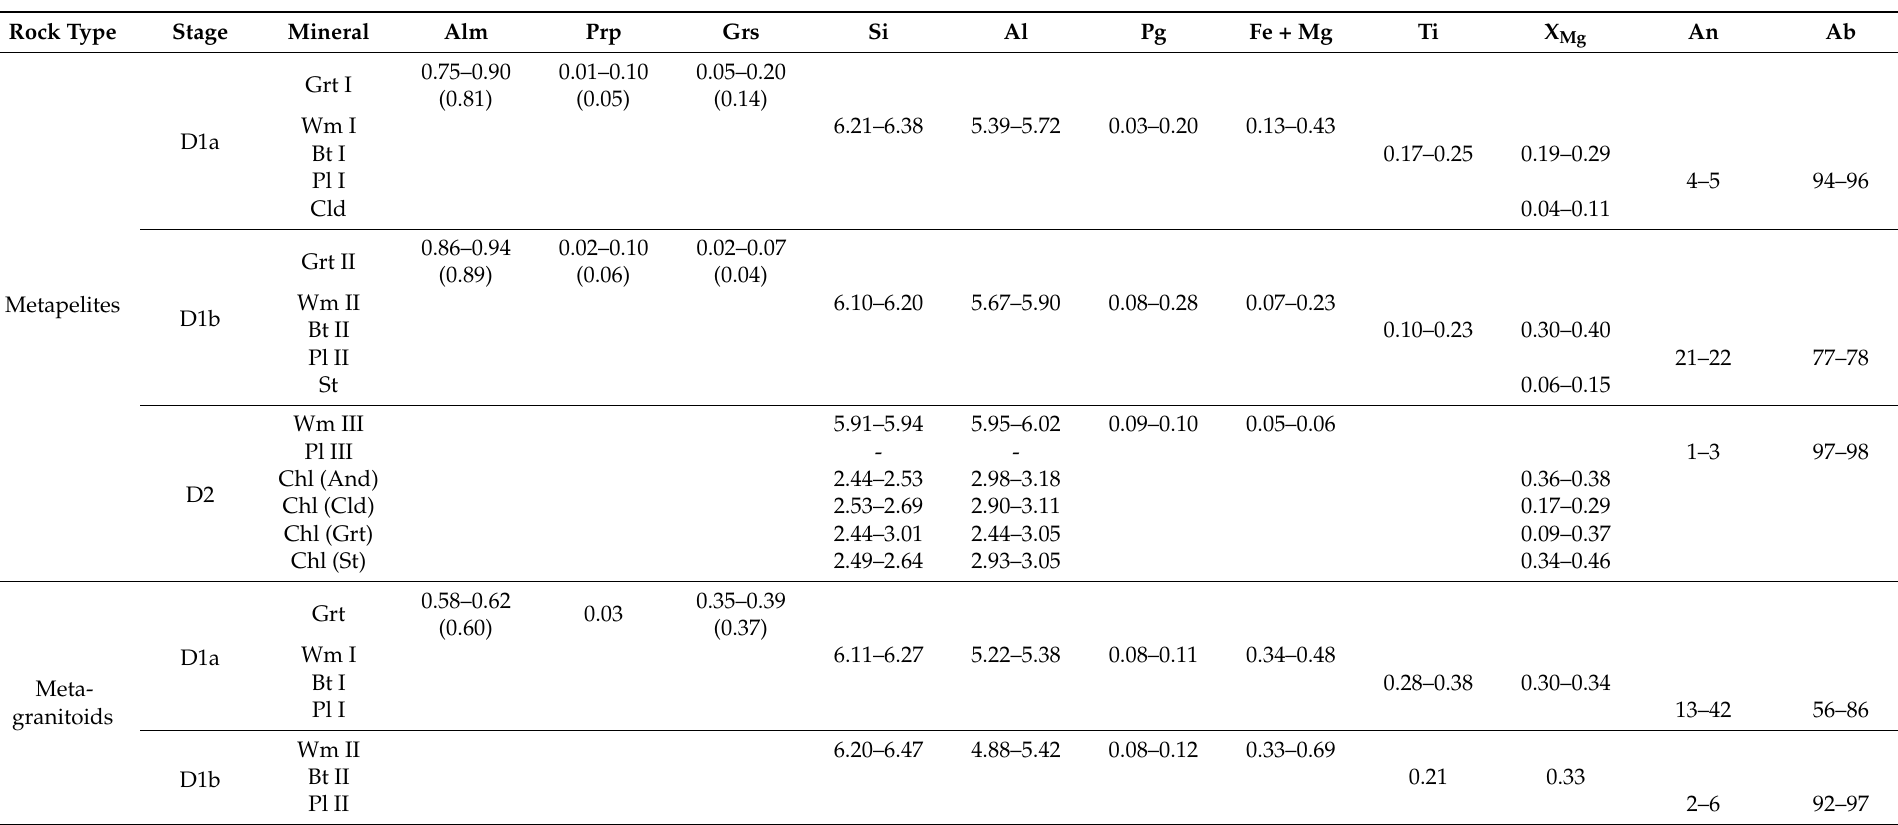
Table 2. Synthesis of mineral chemical analyses. Stoichiometric formulae are calculated as follows: garnet at 8 cations and 12 oxygen atoms, epidote at 8 cations and 12.5 oxygen atoms, biotite and white mica at 22 oxygen atoms, chloritoid at 12 oxygen atoms, staurolite at 46 oxygen atoms, chlorite at 7 oxygen atoms, and plagioclase at 4 oxygen atoms. Average values are in